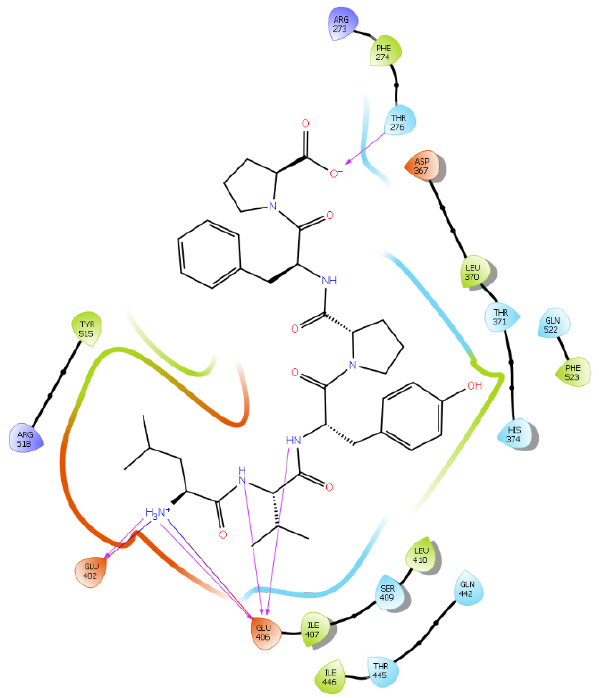
Figure 6. Docking results of the peptide LVYPFP in the human ACE2 active site. The interactions of human ACE2 residues with the peptide (represented in black) are indicated by arrows of different colors, with purple arrows representing hydrogen bond interactions and blue arrows representing salt bridge